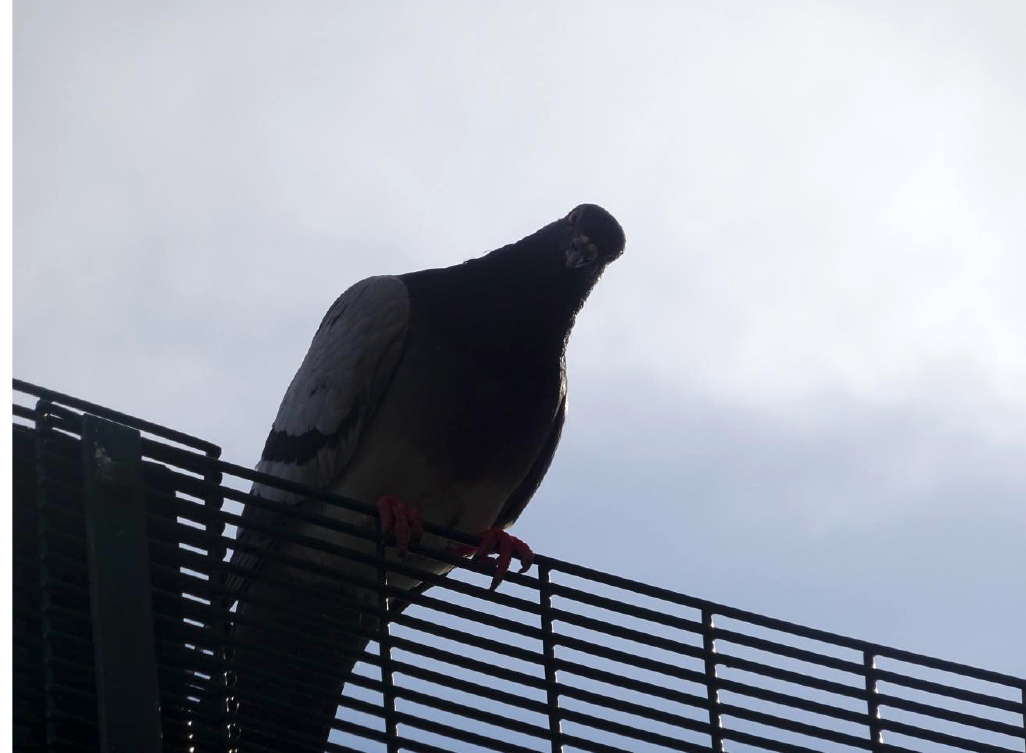
Figure 3. The idea of freedom. Source: Photo taken by an institutionalised